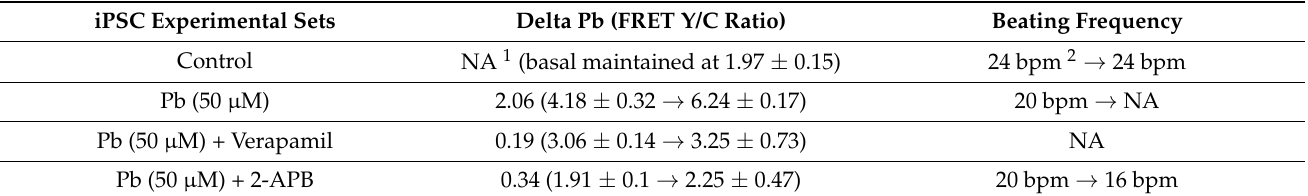
Table 1. Intracellular entry of Pb (FRET ratio changes) and the physiological impact of Pb (beating rate) on iPSC-induced cardiomyocytes. The original data were extracted from Figures 2 and 3. The beating frequency was described in Figure S4.